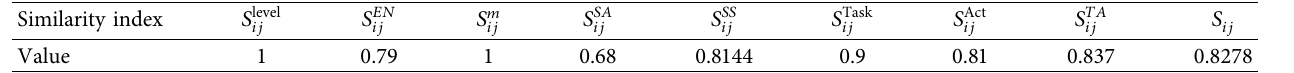
Table 4: Index values of emergency drills scenario